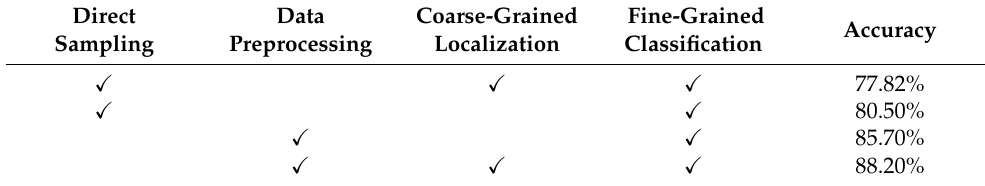
Table 7. The performance of components in our progressive identification approach.